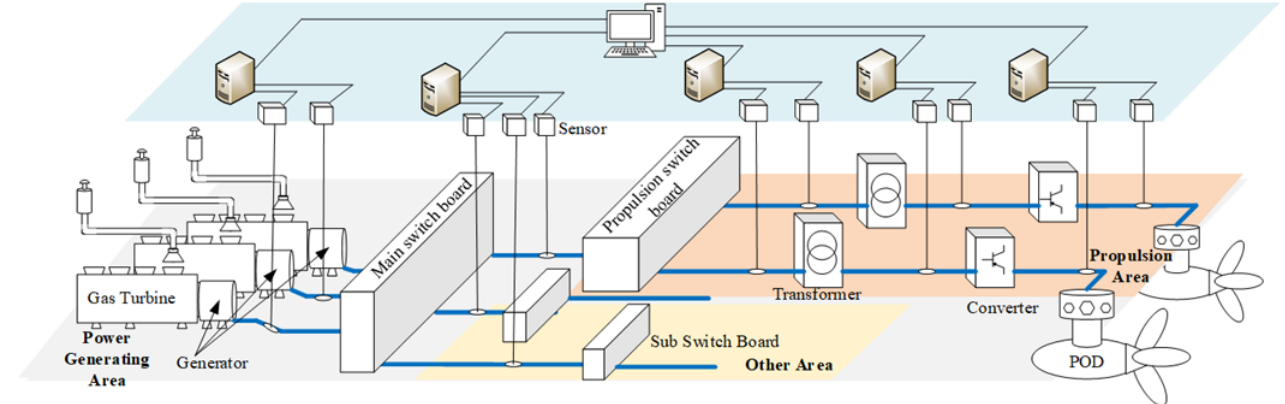
Figure 1. Structure of the main power system on port side of electric propulsion ship.